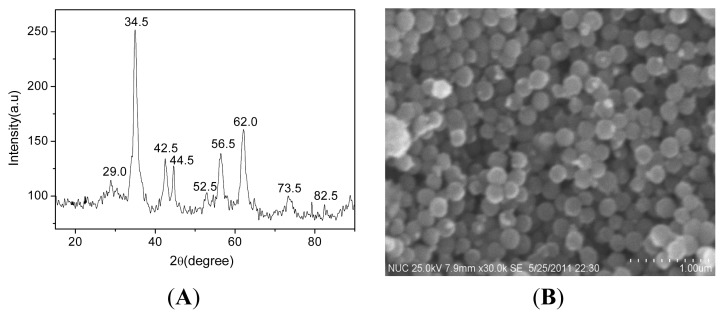
(A) XRD; and (B) SEM image of FeCo/Fe3O4 nanocomposite.